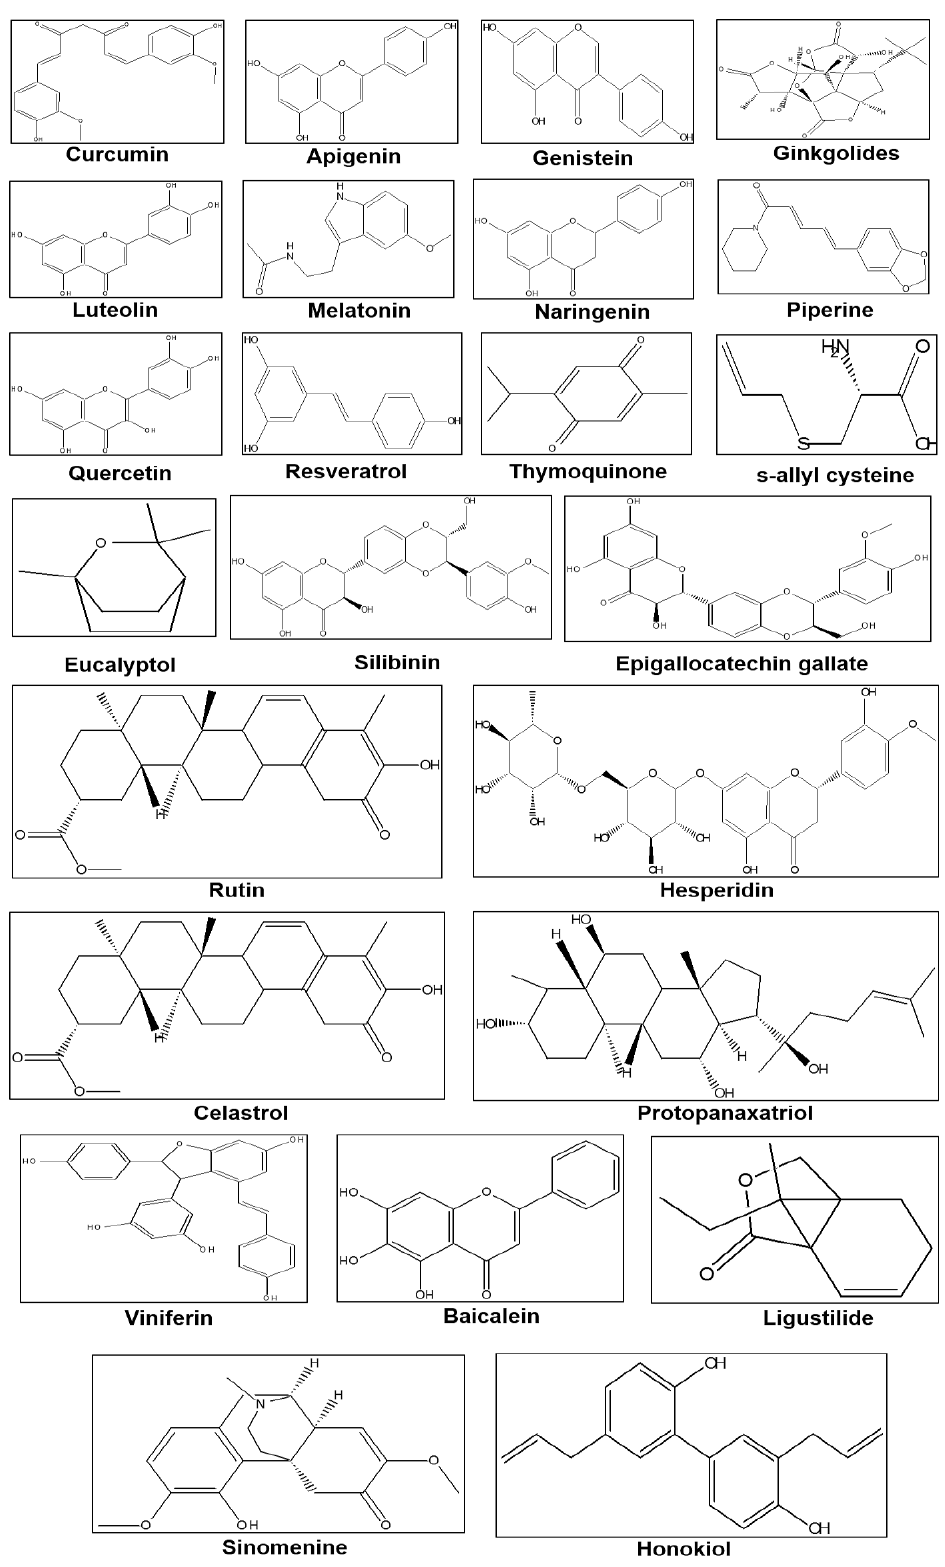
Figure 1. Chemical structures of some common phytochemicals used in the prevention of neurodegenerative diseases (NDs).